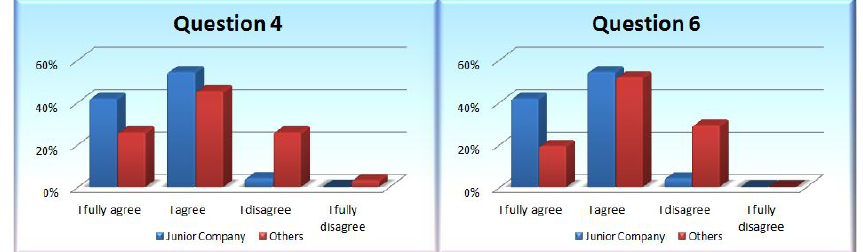
Fig. 4. Comparison between the answers of the two groups to question 4 and question 6